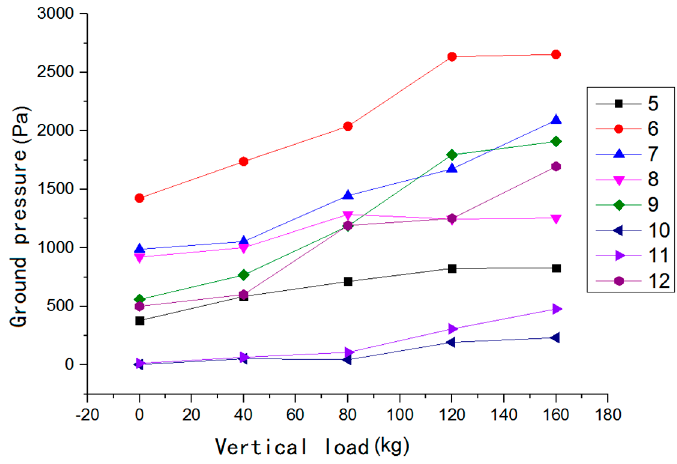
Figure 18. Relationship between ground pressure and vertical load.